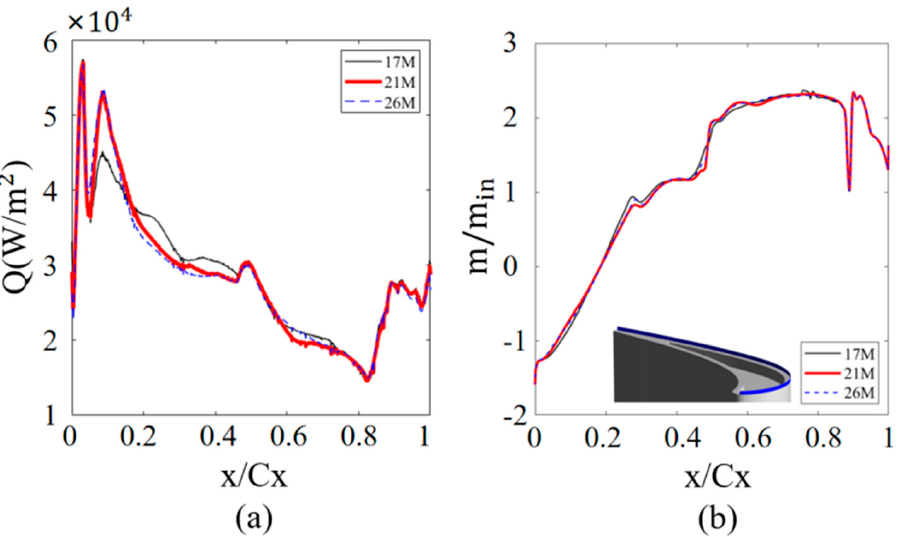
Figure 2. Mesh independence study: ( a ) circumferentially averaged heat flux distribution, and ( b ) OTL mass fl ux distribution, along the x − direction on the tip surface.